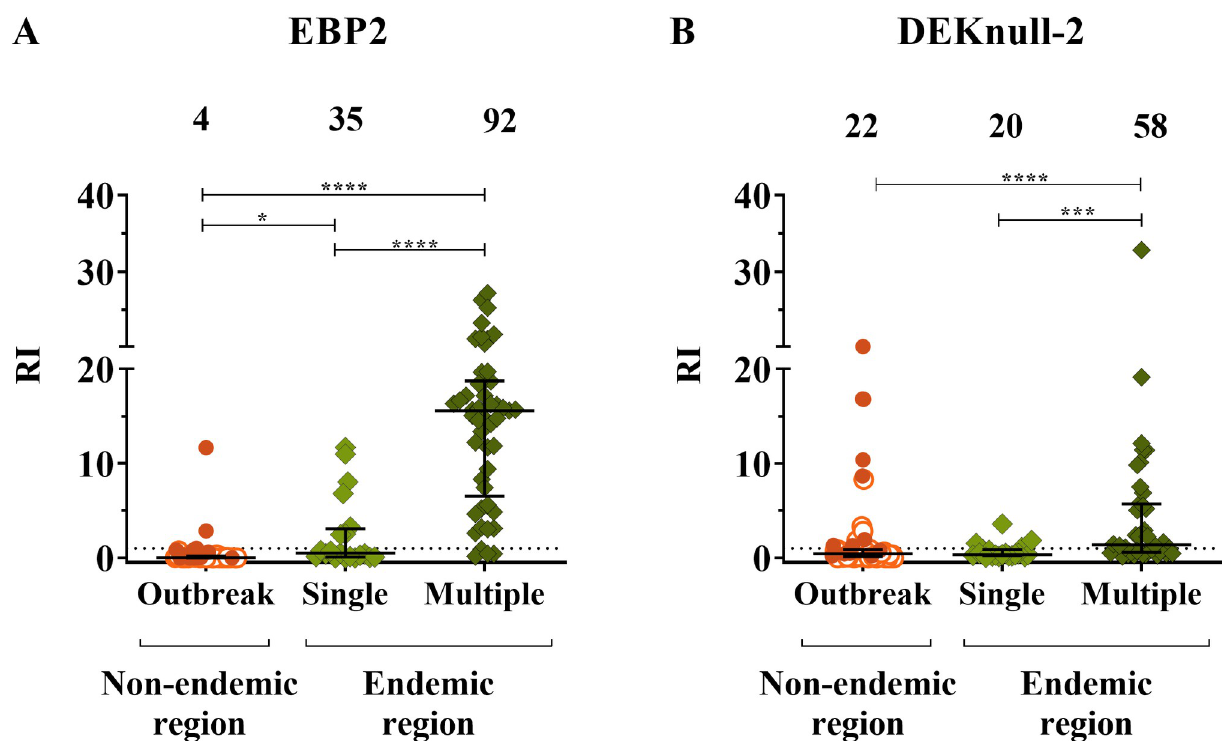
Fig 5. IgG response to distinct P . vivax DBL vaccine candidates among individuals with different previous malaria episodes. Frequency and levels of IgG antibody against P . vivax (A) EBP2 and (B) DEKnull-2 among (1) Outbreak (n = 55)—individuals from non-endemic region, including recurrent P . vivax infection (closed circle) and without recurrence (open circle) and, individuals long-term malaria exposure from endemic region with (2) Single previous malaria episode (n = 20) and multiple episodes (n = 49). Sera reactivity was expressed as ELISA Reactivity Index (RI). Samples with RI > 1.0 were considered positive. The percentage (%) of positive IgG antibody response to each protein was expressed at the top of the graph. Differences statistically significant were indicate by asterisk ( � P < 0.05, �� P < 0.01, ��� P < 0.001, ���� P < 0.0001).